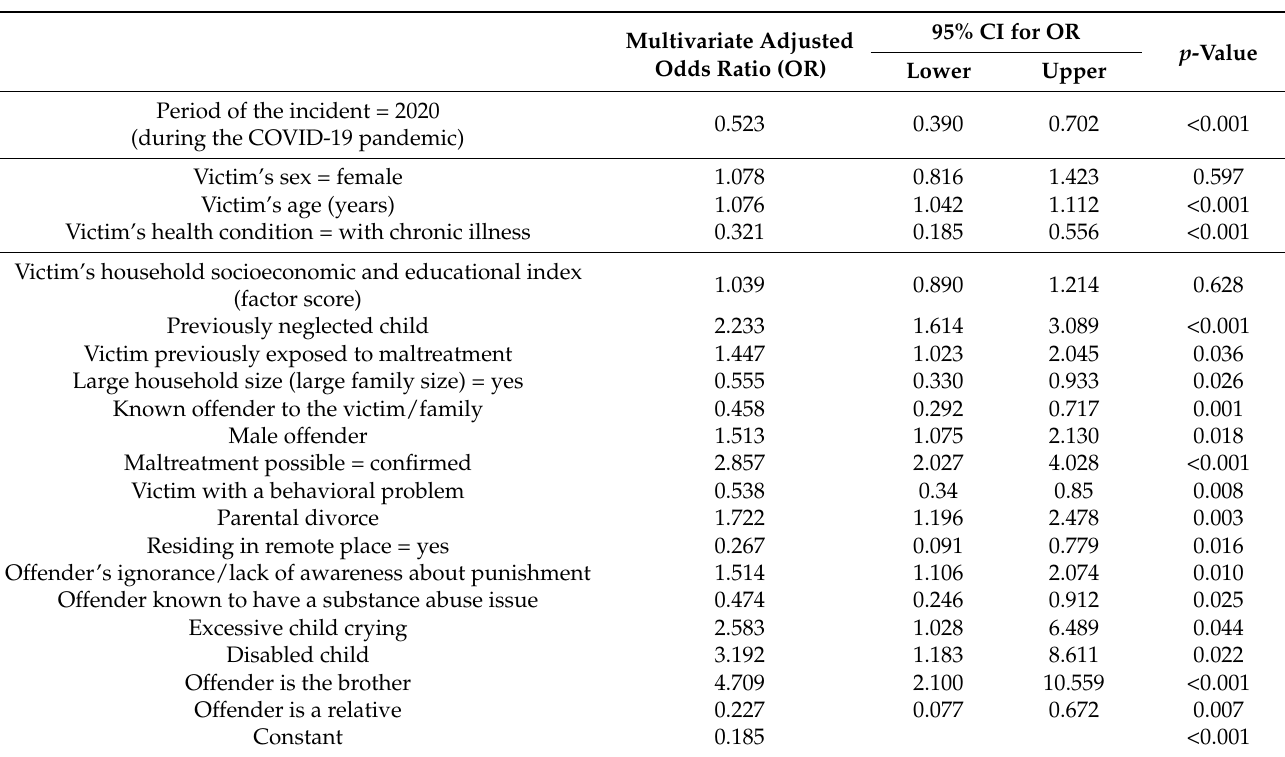
Table 4. Multivariate logistic binary regression analysis of children’s odds of physical maltreatment ( n = 1304).